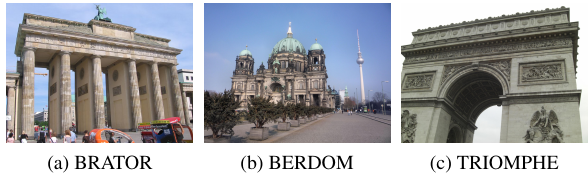
Figure 3. Sample images for each of the three datasets. (a) BRA-